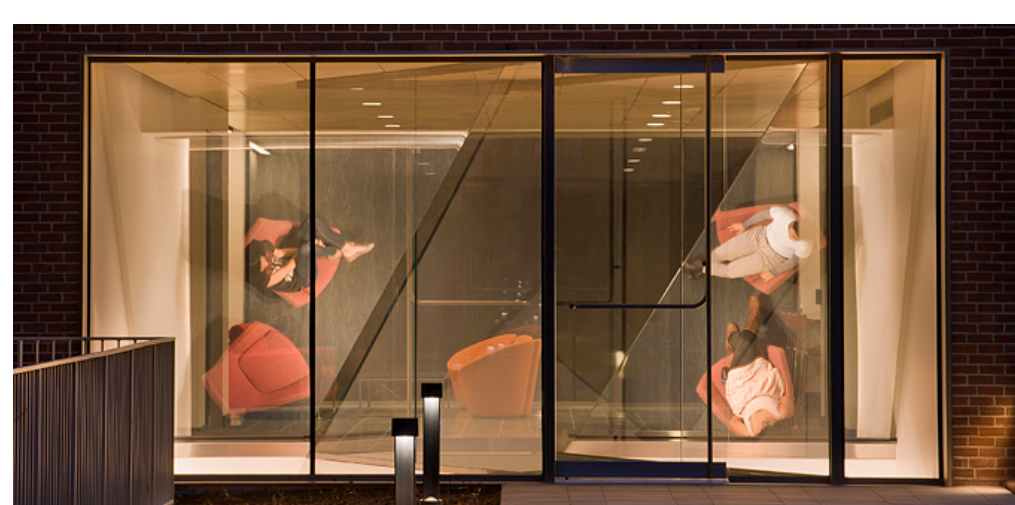
Fig. 2 P-131317, 2011 | Glass and existing architecture | Total dimensions variable Brown University Cognitive Science Building | Providence RI, USA Photo Credit: Warren Jagger | Exterior evening view